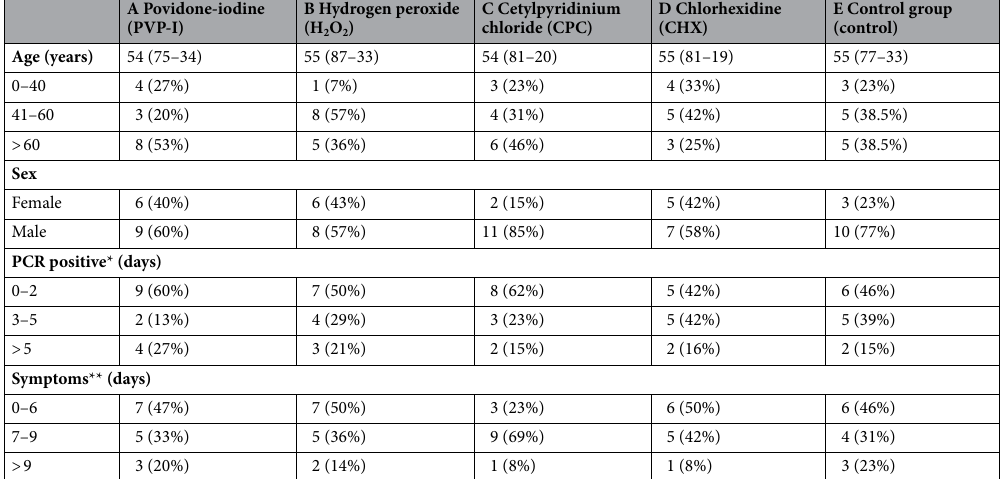
Table 1. Clinical variables registered from the patients included in the study. *Days from the positive SARS- COV-2 PCR test (nasopharyngeal swab) performed at hospital. **Days since the appearance of symptoms related with SARS-COV-2 infection.